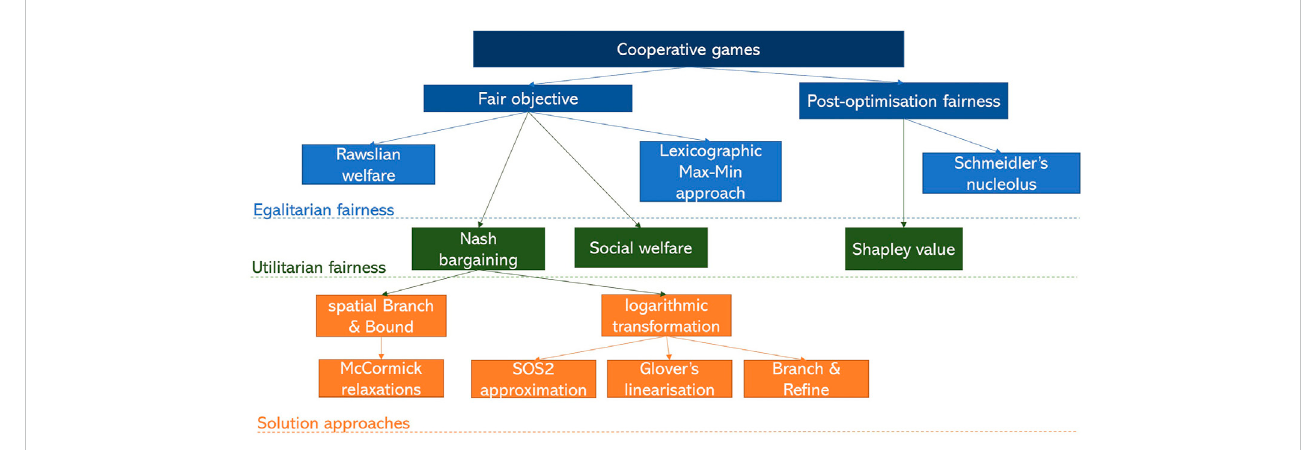
FIGURE 3 Fairness schemes and proposed solution approaches.